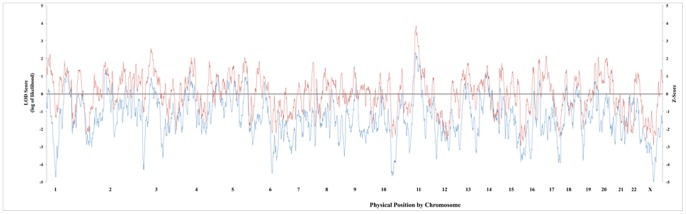
Genome-wide admixture Scan for Type 2 Diabetes.The log (base 10) of the likelihood, referred to as the locus genome statistic, is plotted on the y-axis (in blue) and represents the likelihood of being a disease locus vs. non-disease locus dependent on significant differences in ancestral allele frequencies. The case-control statistic for each SNP is plotted on the secondary y-axis (in red) and is represented as a Z-score.